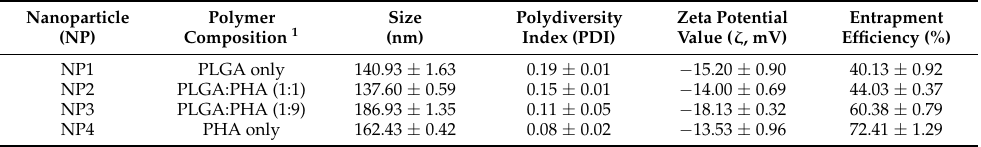
Table 1. Physicochemical properties of